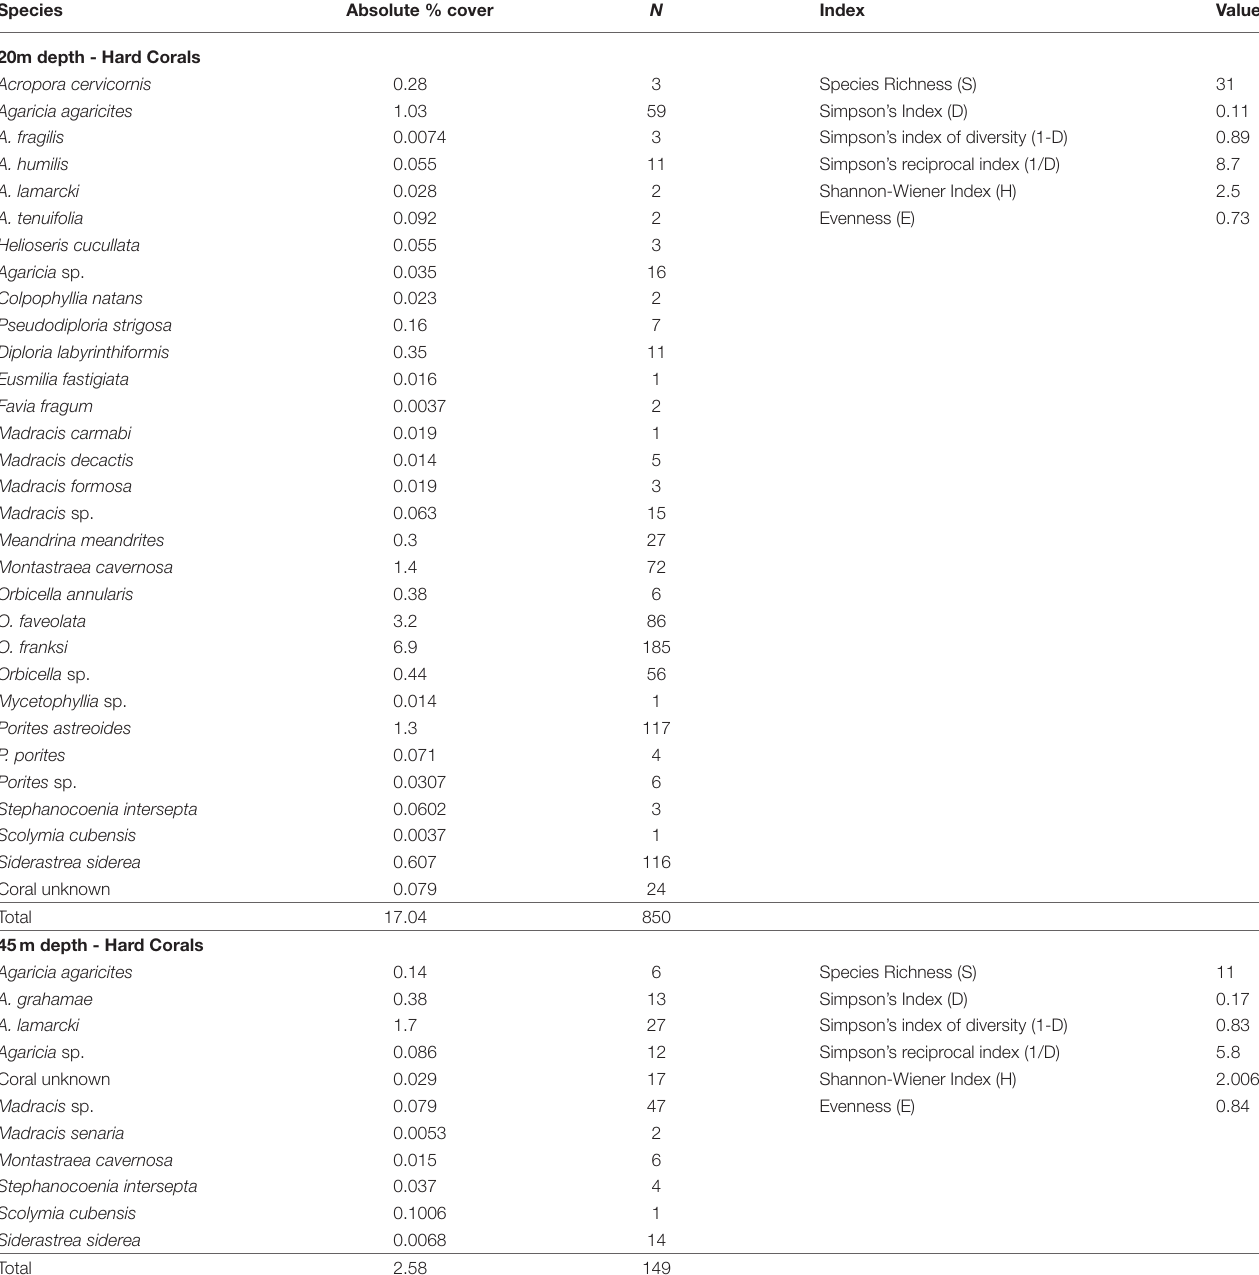
TABLE 4 | Scleractinian species identified in deep (45m) and altiphotic (20m) transect surveys from the central portion of Guánica shelf edge, southwest Puerto Rico; ∼ 40 m 2 was surveyed per depth designation.